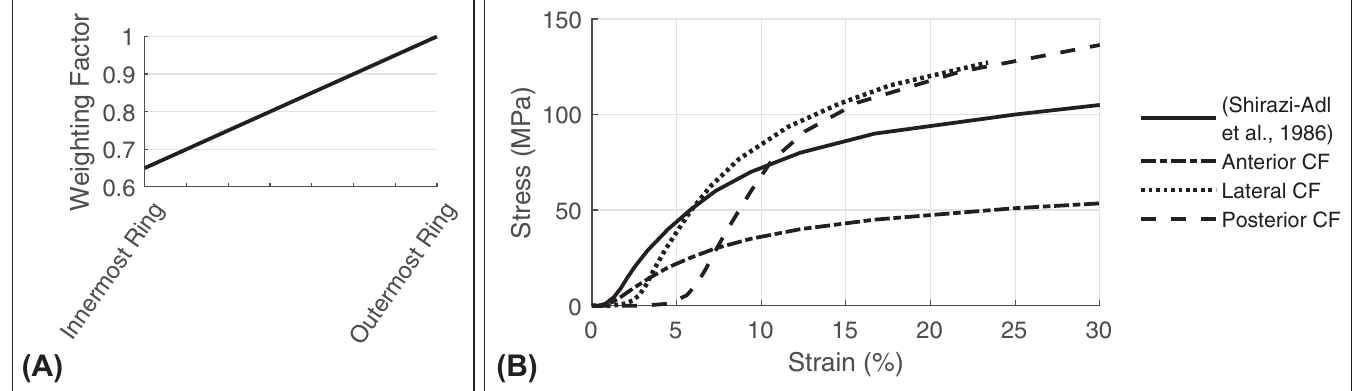
Fig 3. (A) Linear stiffness gradient and (B) stress strain curves of the collagen fibers. (B) The initial course of the stress-strain curve is taken from the literature [105] and adjusted during calibration process. A distinction is made between the three anatomical directions of the disc in which the CF are located: anterior, posterior, and lateral (compare Fig